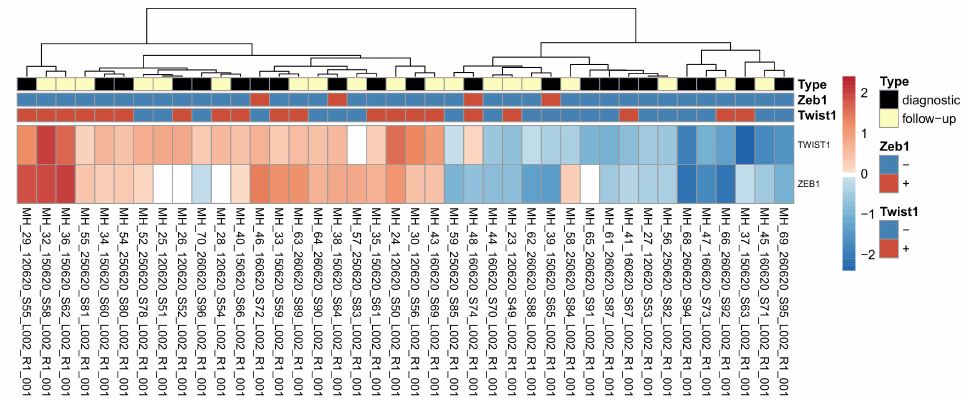
Figure 2. Comparison of immunohistochemical and RNA levels of Twist1 and Zeb1 in analyzed samples. First three rows indicate diagnostic and follow-up samples, Twist+ and Twist- and Zeb+ and Zeb- immunohistochemistry. Heat map of normalized read counts (normalized with the VST method in DESeq2) for all analyzed samples for TWIST1 and ZEB1 RNA. The rows are scaled so that blue indicates below-average expression for the gene, and red indicates above-average